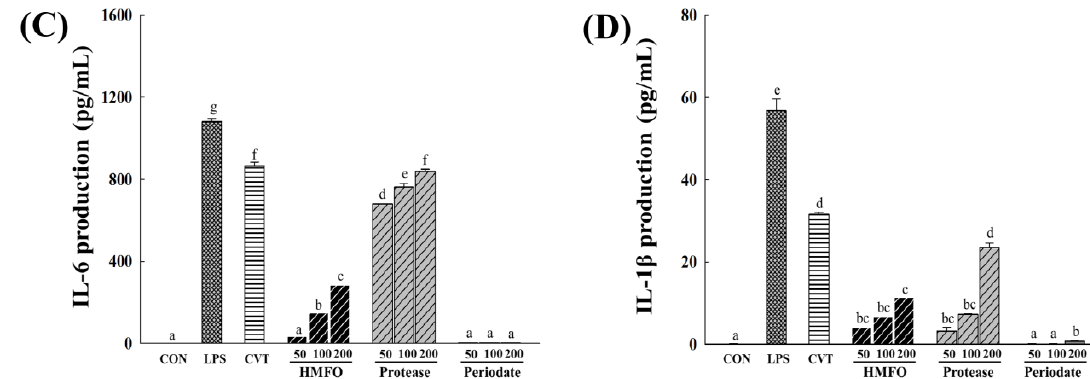
Figure 4. Effects of chemical and enzymatic treatments of HMFO on immunostimulatory activity in